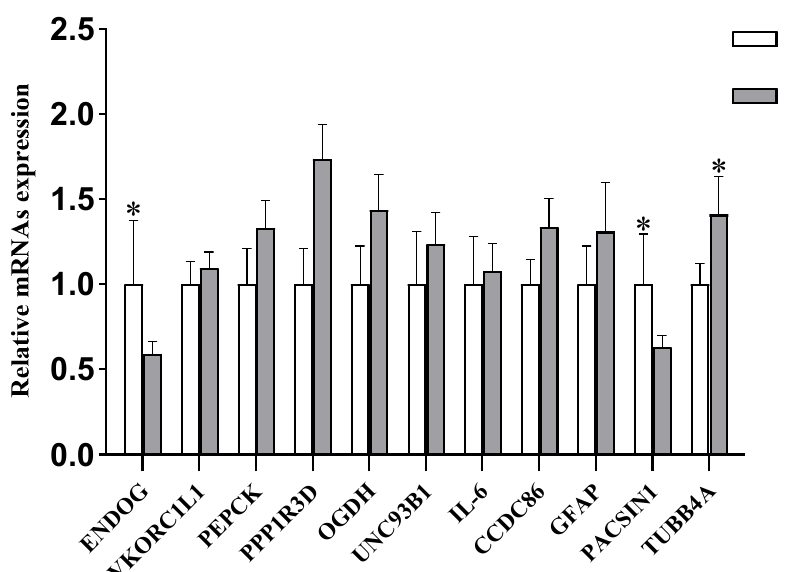
Figure 11. Validation of DAPs by RT-PCR, the relative expression of mRNA. Values are means, with their standard errors represented by vertical bars, * means p < 0.05. ENDOG, endonuclease G; VKORC1L1, vitamin K epoxide reductase complex subunit 1 like 1; PEPCK, phosphoenolpyruvate carboxykinase 2; PPP1R3D, protein phosphatase 1 regulatory subunit 3D; OGDH, oxoglutarate dehydrogenase; UNC93B1, unc-93 homolog B1; IL6, interleukin 6; CCDC86, coiled-coil domain containing 86; GFAP, glial fibrillary acidic protein; PACSIN1, protein kinase C and casein kinase substrate in neurons 1; TUBB4A, tubulin beta 4A class Iv .